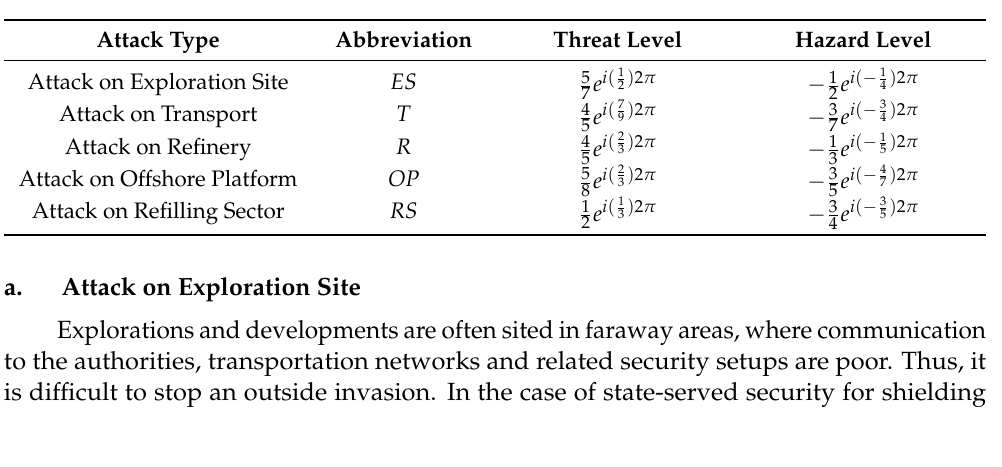
Table 2. Abbreviation and mathematical values for Terrorist